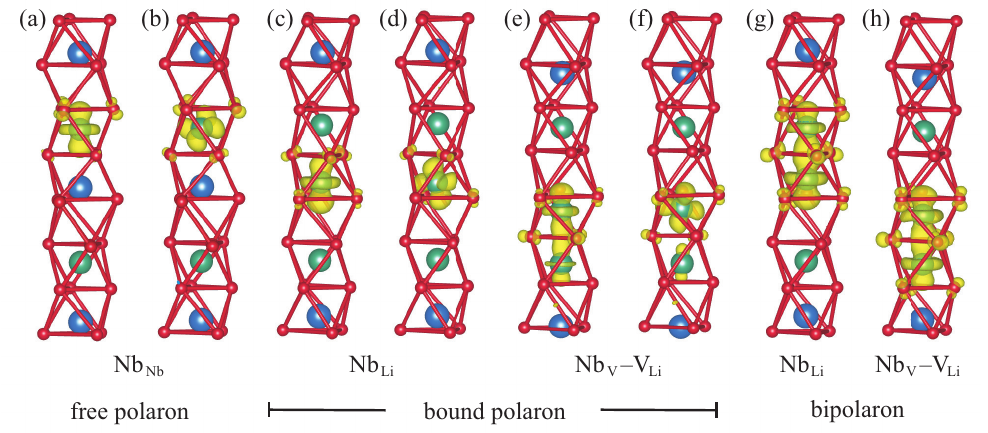
Figure 4. Charge densities of the free polaron ( a , b ), the bound polaron at a Nb Li antisite defect ( c , d ) or a Nb V –V Li defect pair ( e , f ), and the bipolaron at Nb Li ( g ) or Nb V –V Li ( h ). Subfigures ( b , d , f ) refer to tilted configurations, all other structures exhibit axial symmetry. Blue, green, and red balls represent lithium, niobium, and oxygen atoms, respectively. Reproduced from